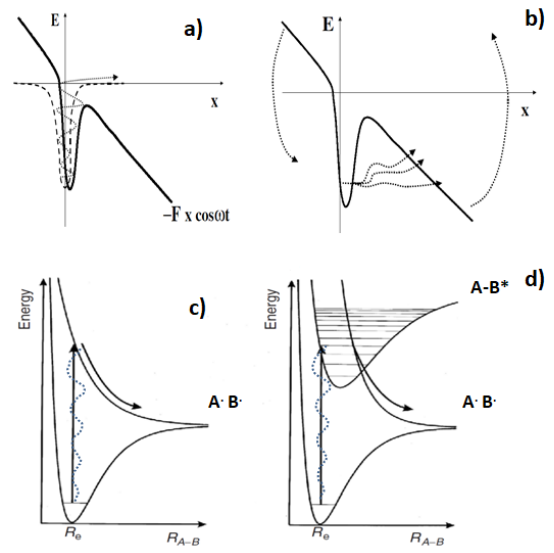
Figure 2. The absorption of several (n) photons can result in multiphoton dissociation (MPD), as well as multiphoton ionization (MPI). ( a ) MPI ionization, Keldysh parameter γ >> 1; ( b ) ionization according to the tunneling mechanism, γ << 1; ( c ) MPD according to direct dissociation; ( d ) MDP according to predissociation.